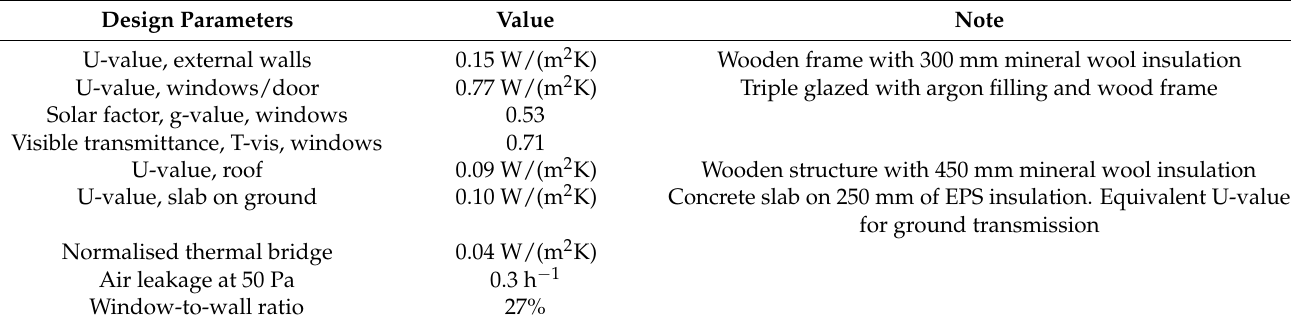
Table A3. Main envelope parameters for the case study building.